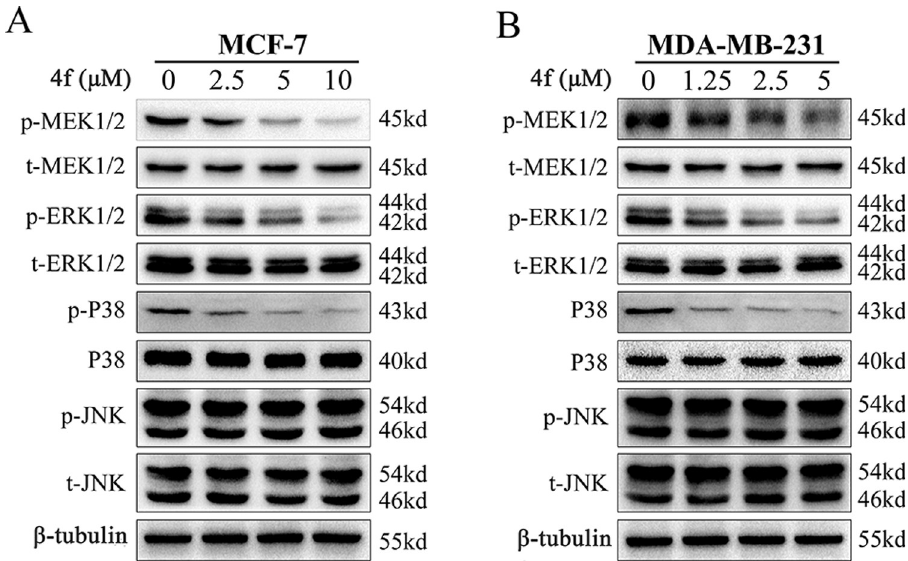
Fig 6. 4f inhibits MEK/ERK and p38 MAPK pathways in breast cancer cells. Cells were treated with 4f at a concentration of 0 μ M, 2.5 μ M, 5 μ M, 10 μ M in MCF-7 cell line (A) and a concentration of 0 μ M, 1.25 μ M, 2.5 μ M, 5 μ M in MDA-MB-231 cell line (B) for 24 h, the expression of phosphorlated and total ERK1/2, p38, JNK and MEK1/2 were detected by western blotting assays. All the data repeated for three times.